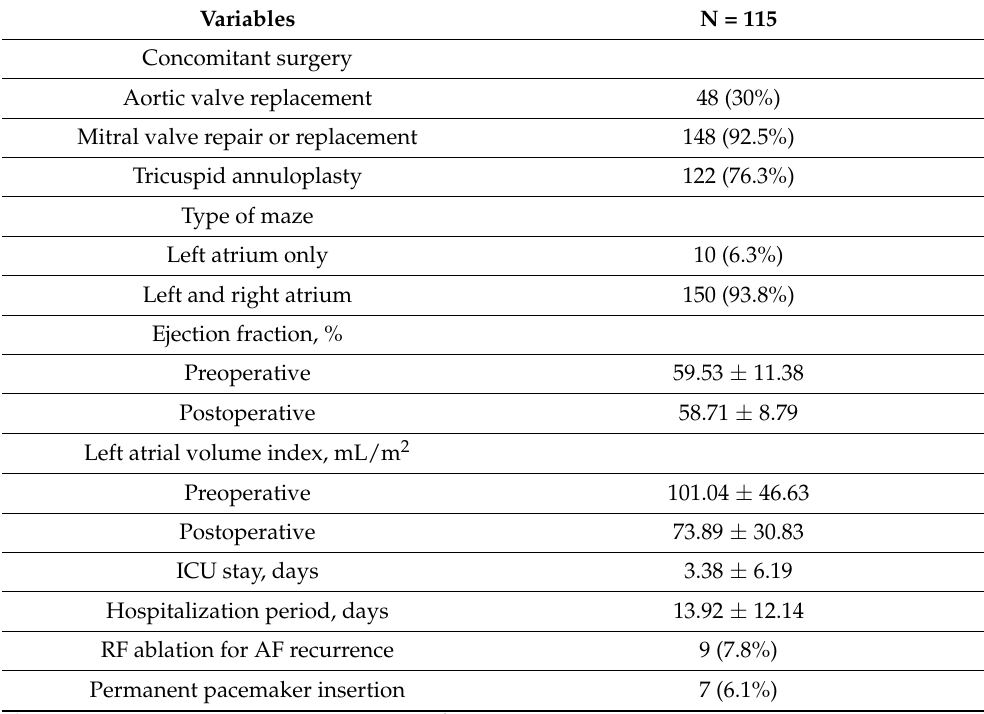
Table 2. Operative data.